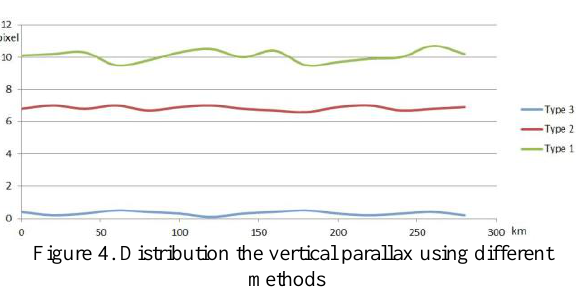
Figure 3. Distribution the horizontal accuracy using different methods